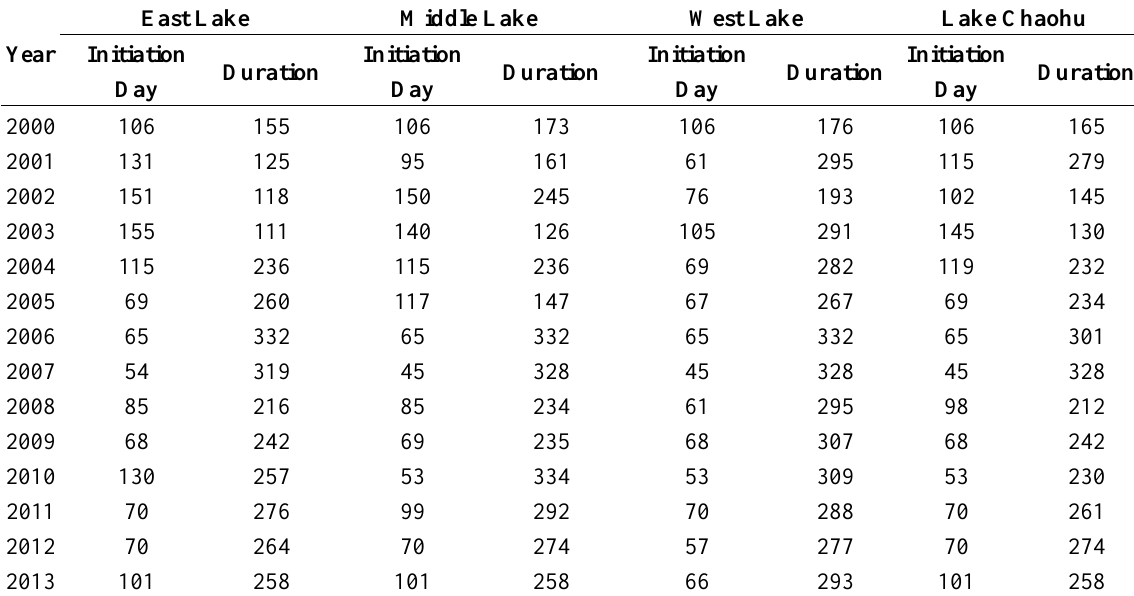
* The values shown represent the starting days (1–366) and durations (in days) of significant algae bloom. “Significant” was defined as when the bloom algae area (floating algae coverage≥ 0) exceeded 25% of the total surface area of the lake segment. Duration was defined as the difference between the last and first days when significant bloom